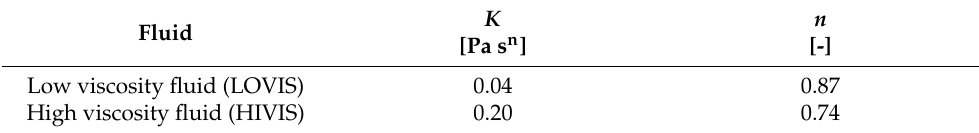
Table 3. Fluid rheological model parameter. Fluid